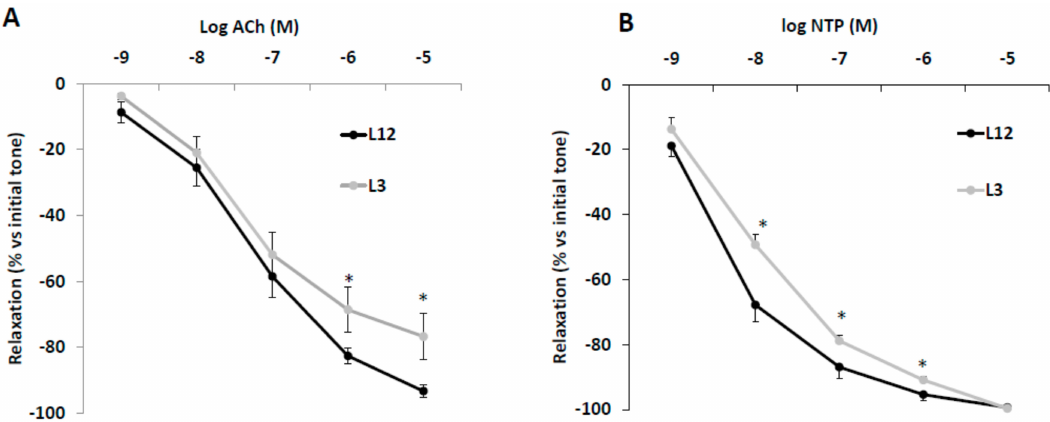
Figure 4. Relaxation caused by ( A ) acetylcholine (Ach, 10 − 9 –10 − 5 M) or ( B ) sodium nitroprusside (NTP, 10 − 9 –10 − 5 M) in precontracted aortic rings from rats raised in L12 or L3 litters. Note: * p < 0.05 di ff erence between aortic rings from L3 and L12. Values are expressed as percentage of initial tone and represented as mean ± SEM ( n = 9–12 rats / experimental group). Data were analyzed by Student’s t -test for each insulin